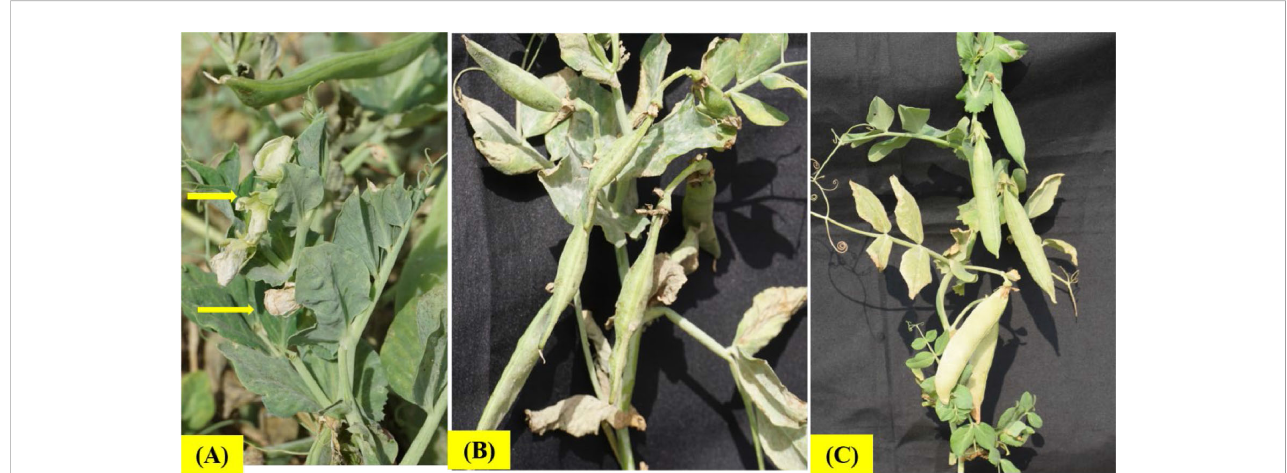
FIGURE 1 Genotypic differences for heat tolerance in vegetable peas at Indian Council of Agricultural Research (ICAR)-Indian Institute of Vegetable Research, Varanasi, India, showing heat sensitivity at temperature ≥ 32°C, (A) Effect of HS on fl oral parts; (B) Misshaped and un fi lled pods in the heat sensitive genotype; (C) Duly fi lled pod formation in the heat tolerant